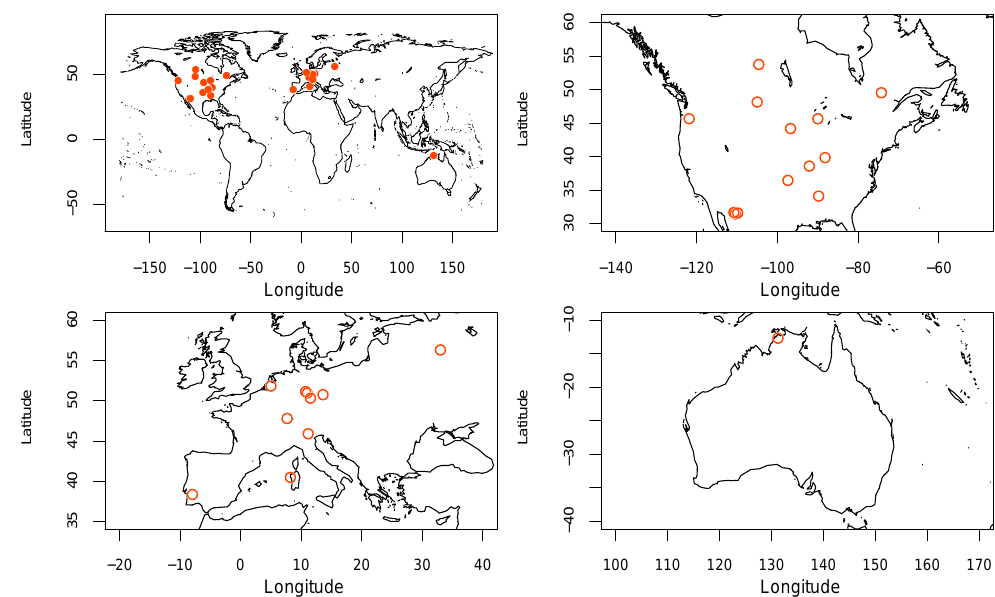
Figure 2. Location of the 24 FLUXNET stations used for the main analysis of the study. They are located on three different continents, encompassing nine different biomes, i.e., vegetation mosaic, croplands, mixed forests, deciduous forest, savanna, evergreen needleleaf forests, grasslands, woody savanna and